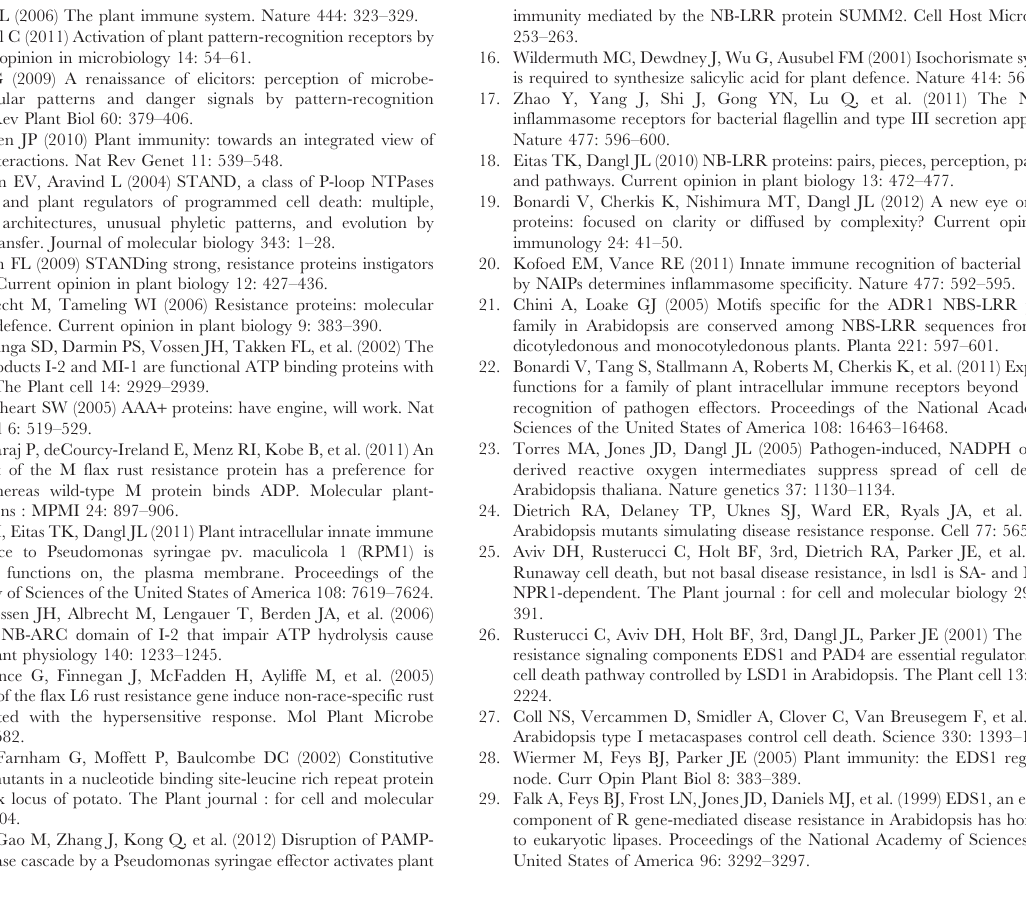
(TIF) Figure S4 LSD1 negatively regulates EDS1 transcript. Quanti-